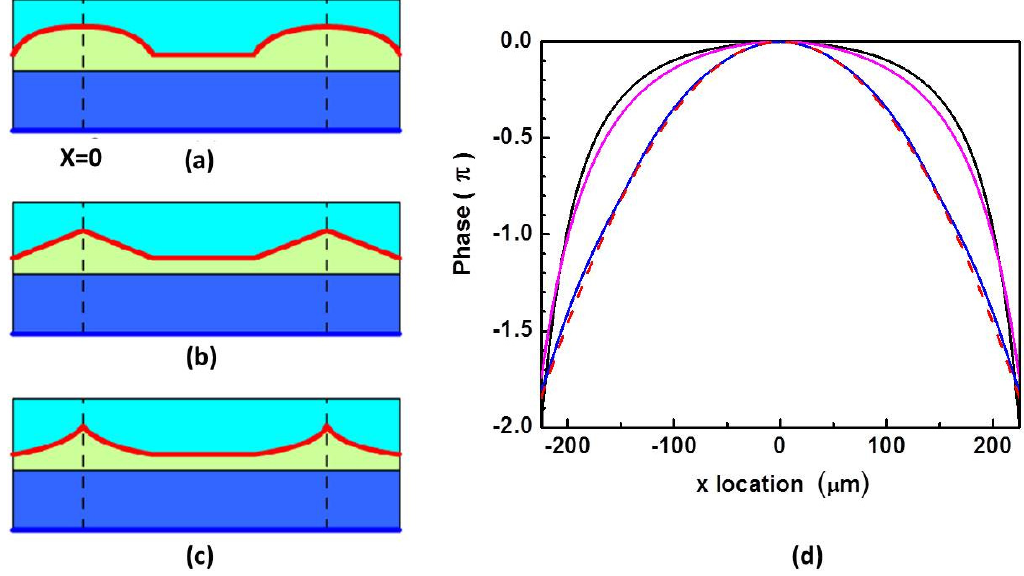
Figure 12. ( a ), ( b ) and ( c ) Microlens structures with different top ITO electrode shapes, and ( d ) the simulated phase profiles: black line for structure ( a ), pink for structure ( b ), blue line for structure ( c ), and red dashed lines for an ideal parabolic